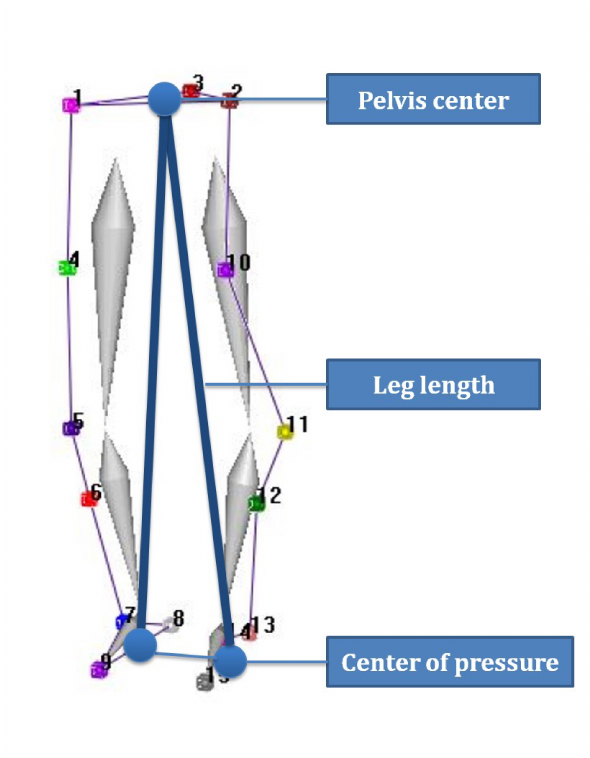
Fig. 1. Marker attachment